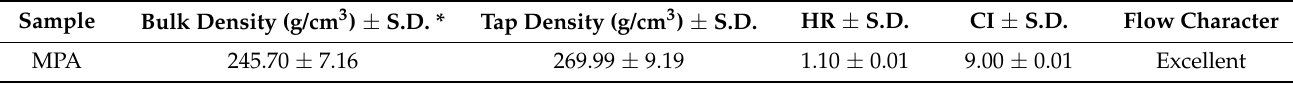
Table 8. Flow properties of MPA powder.